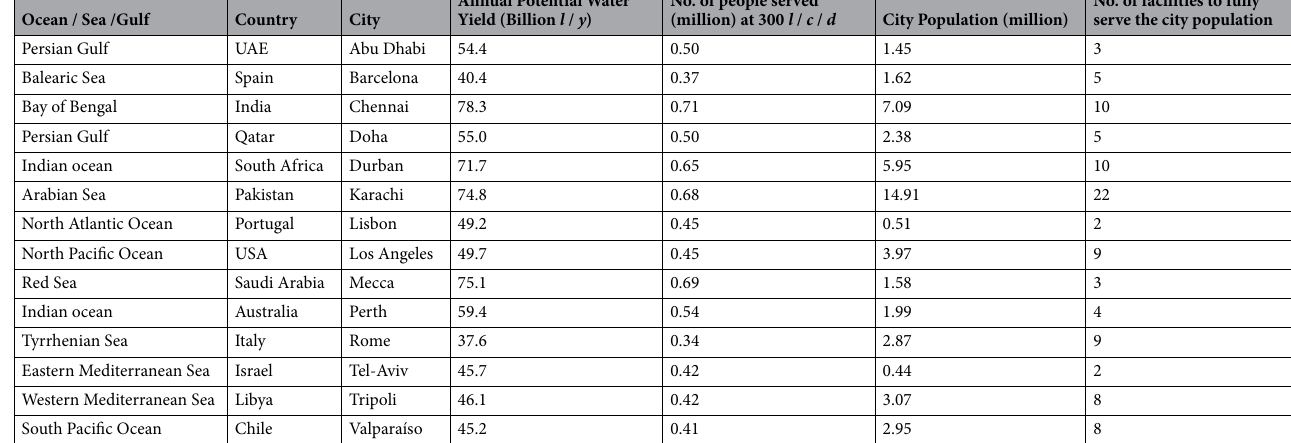
Table 1. Assessment of the volume of annual water yield from a facility of dimension 210 m in width and 100 m in height placed closest to large cities in water-stressed zones and the number of people it can serve to meet their entire need estimated at 300 liters ( l ) per capita per